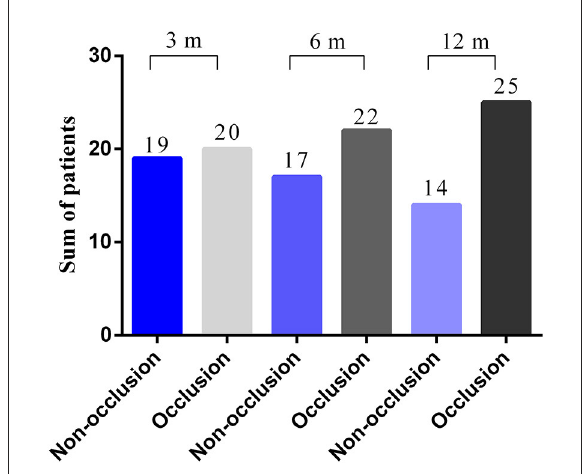
FIGURE2 Patency rates at follow-up. The patency rates at 3, 6, and 12 months were 48.72, 43.59, and 35.90%,